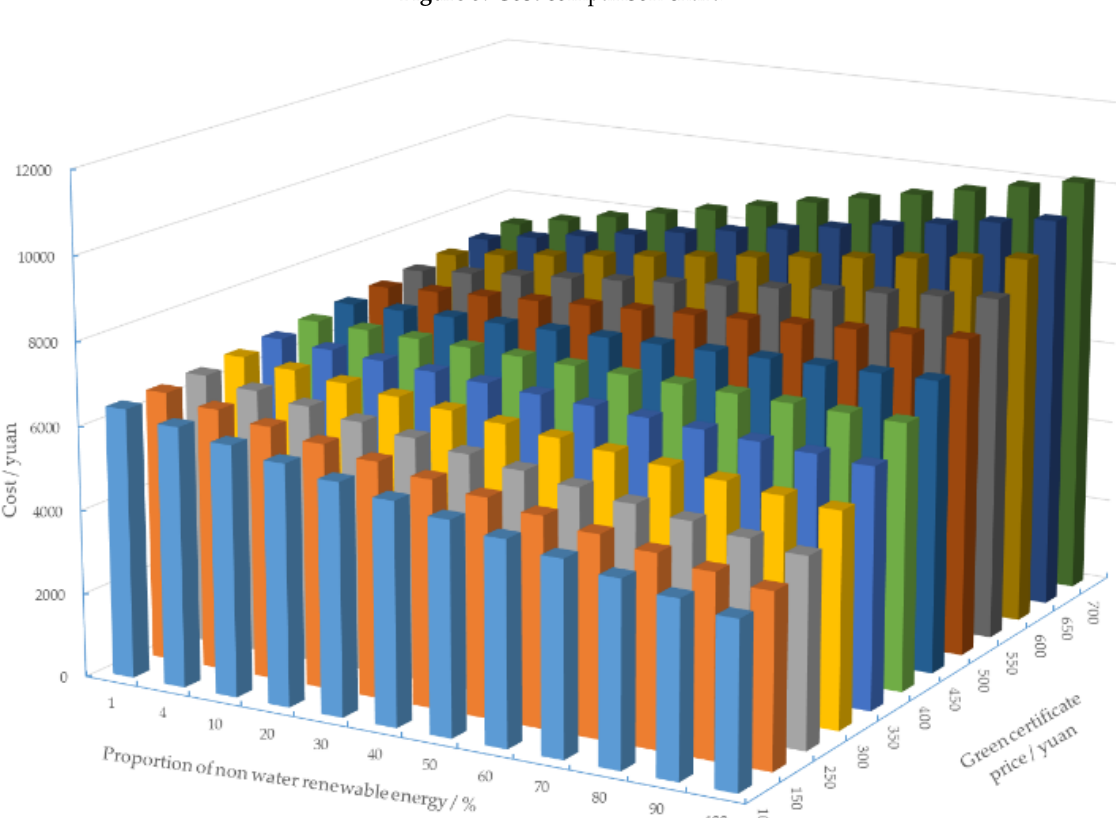
Figure 6. Cost comparison under different green certificate prices and different proportion of the responsibility of renewable energy consumption.